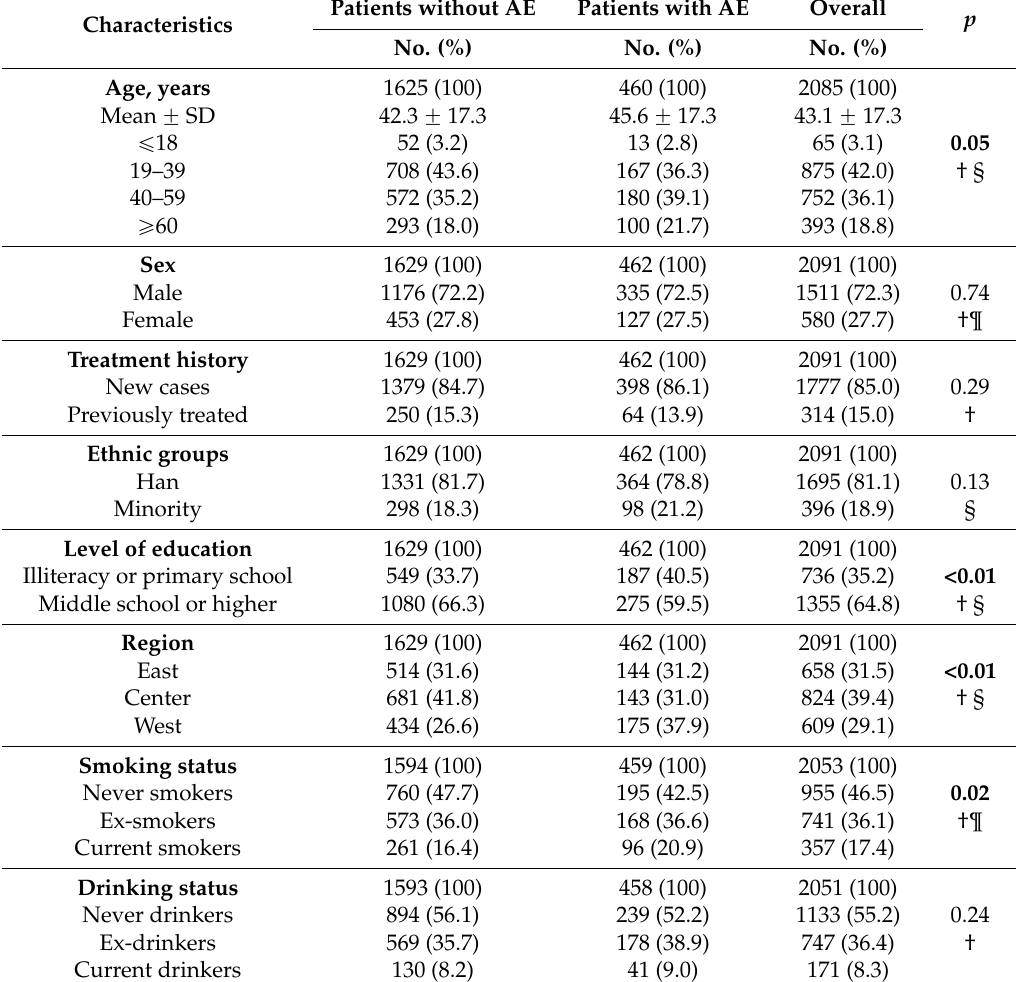
Table 1. Baseline characteristics of the patients ( n = 2091) and results of single risk factor analysis. Patients without AE Patients with Characteristics